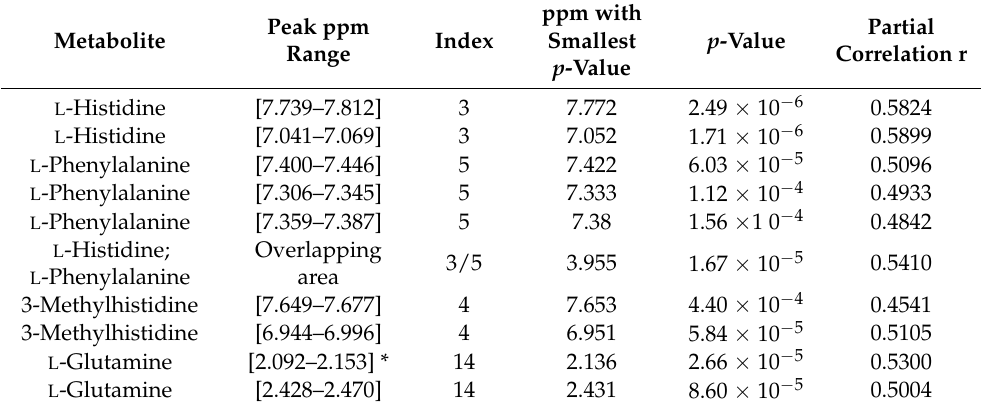
Table 2. Metabolites associated with response at first dose at FDR 95% confidence level ( p -value < 2.3 × 10 − 4 ). The partial Spearman correlation between response and each NMR fea- ture was adjusted for age and sex. Significant spectral areas that were assigned to a known metabolite along with the partial correlation coefficient (r) and smallest associated p -value is shown. Index is the numbering used in Figure 1. Positive r indicates direct association with high response at first